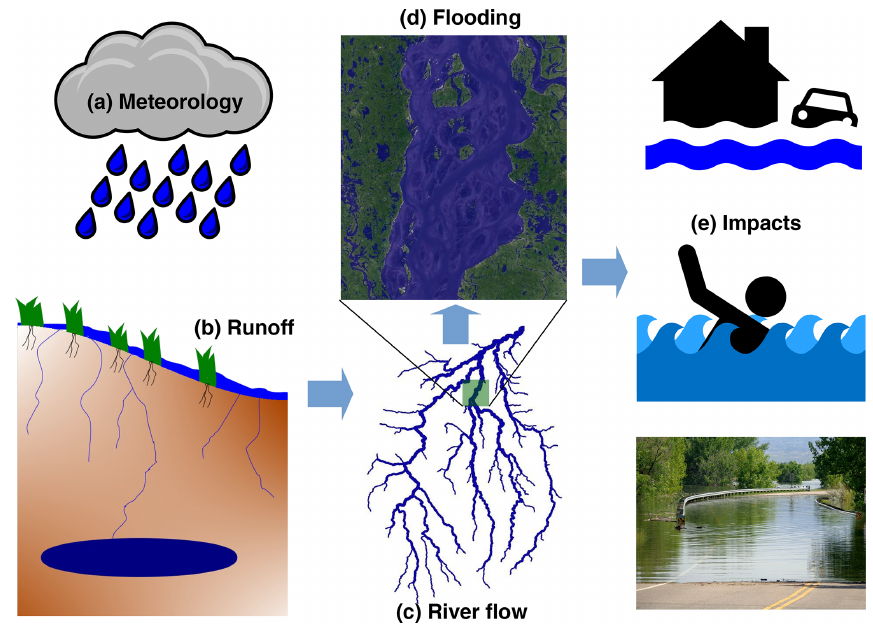
Figure 1. Schematic of modeling steps to determine flood impacts from meteorological forcings. The impacts in (e) (not modeled in this study) can be related to different sectors, e.g., human health, transport, agriculture, and property damage.